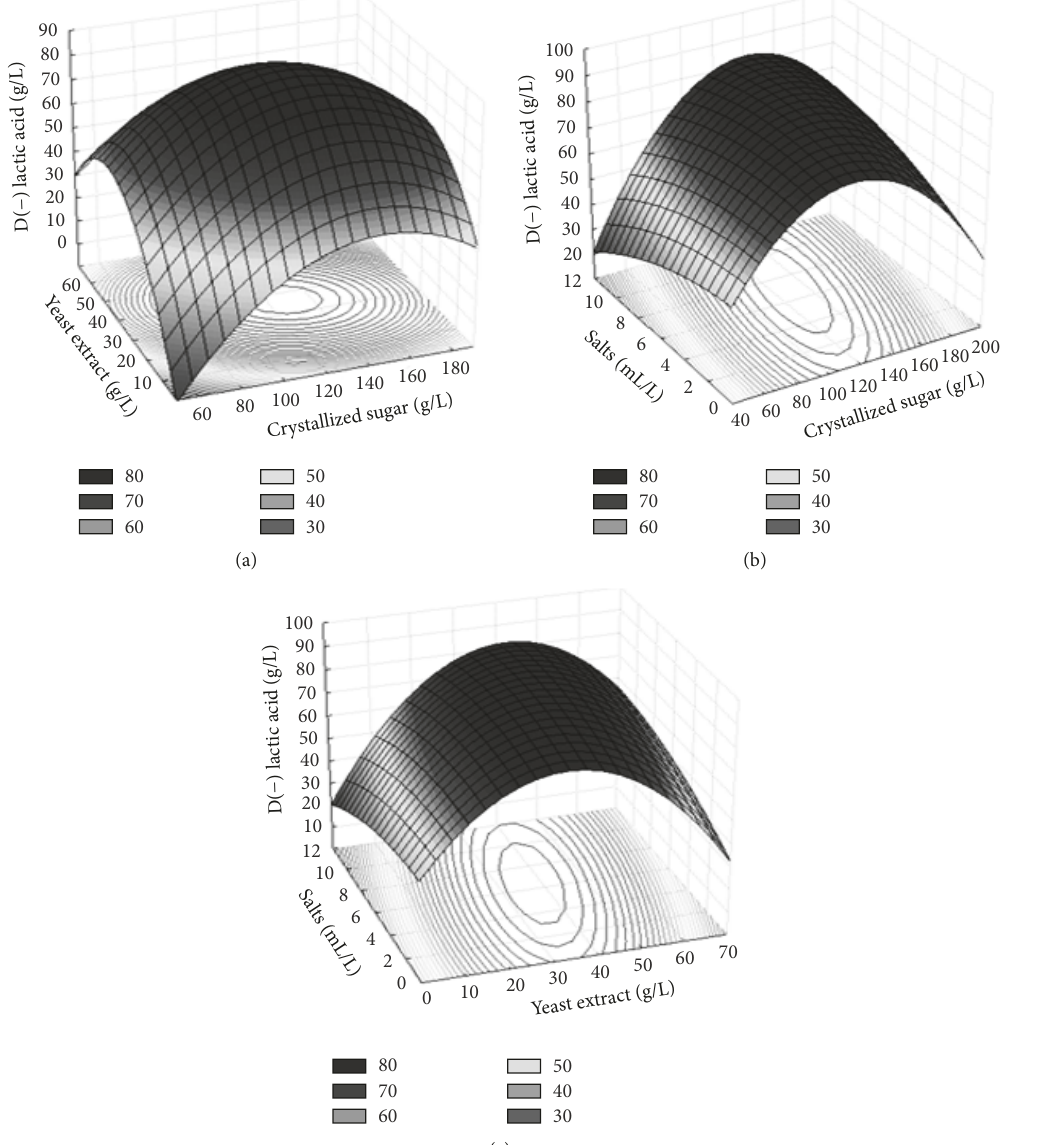
Figure 1: Response surface for lactic acid production by S. nakayamae . Interactions between (a) yeast extract and crystallized sugar, (b) salts and crystallized sugar, and (c) yeast extract and salts.